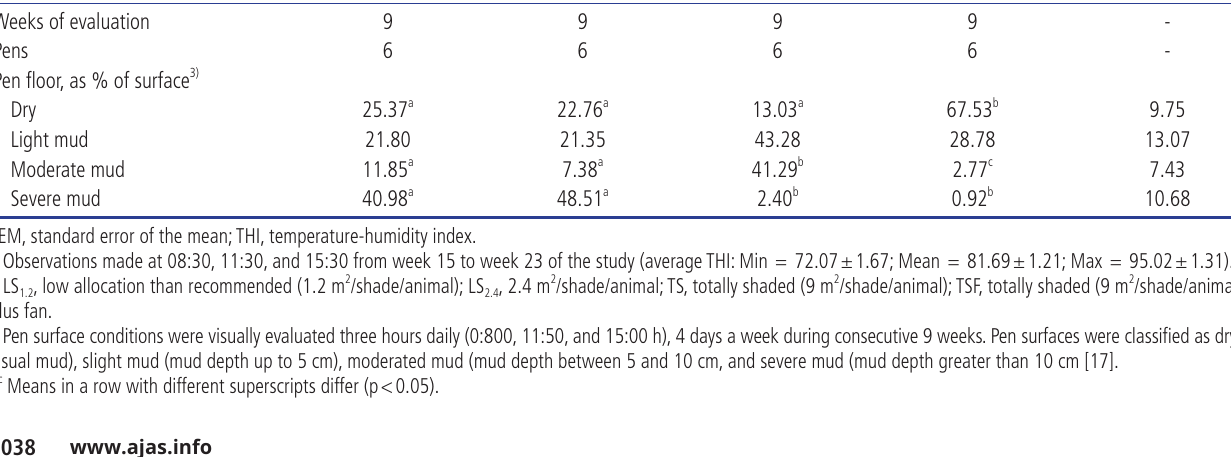
Table 3. Influence of shade treatments on pen surface conditions 1)